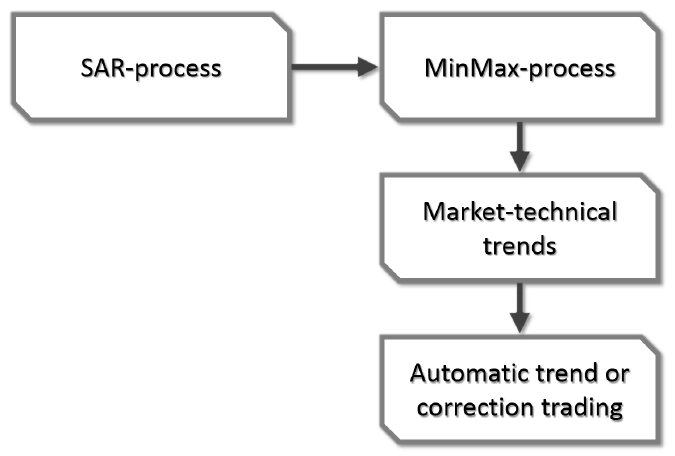
Figure 2. General concept of the automatic detection of